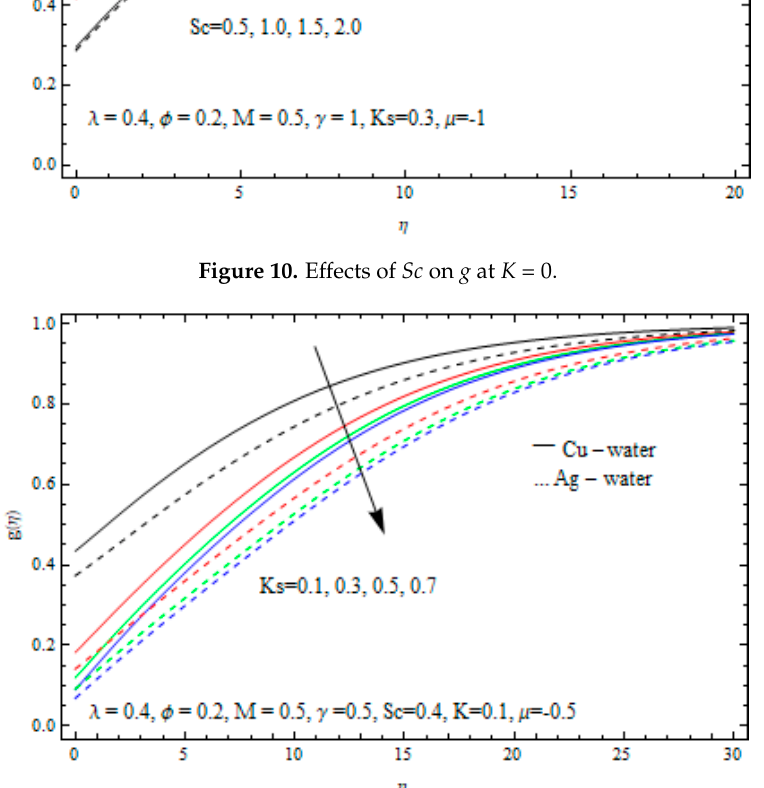
Figure 11. Effects of Ks on g .